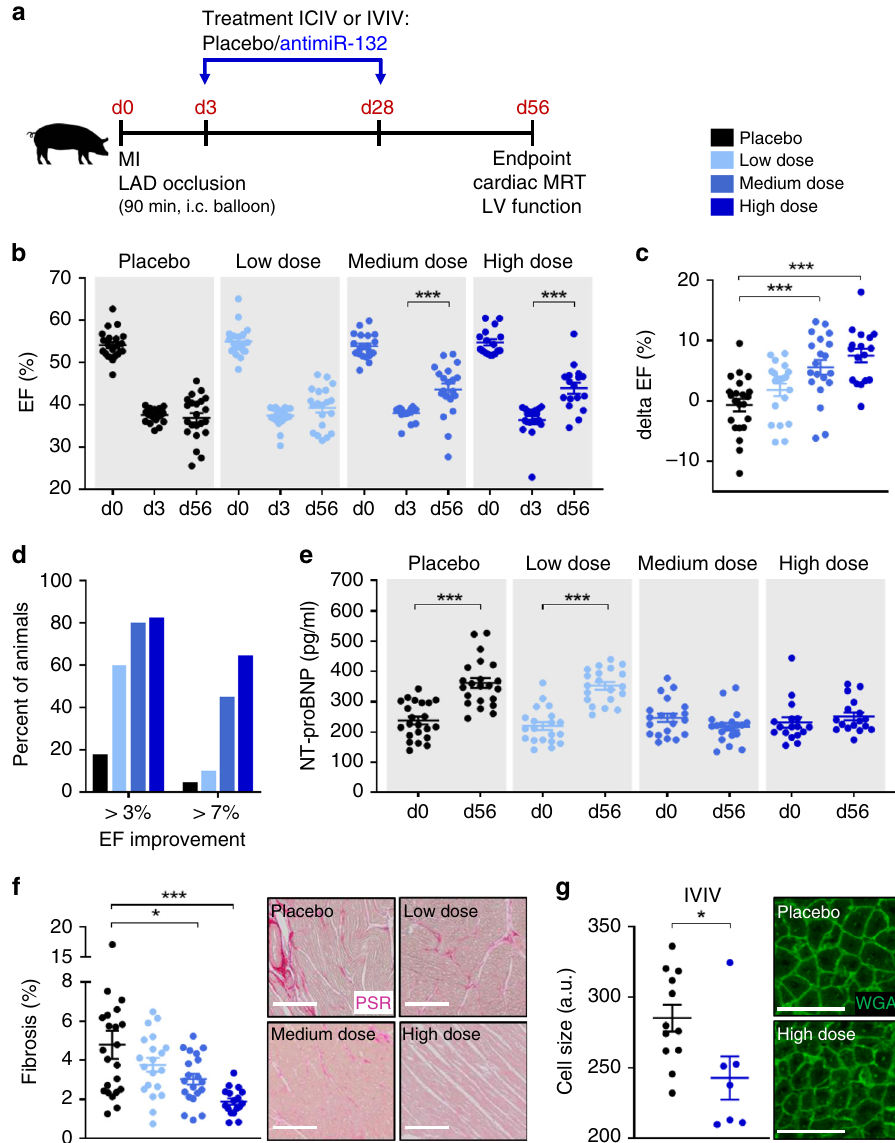
Fig. 4 Proof-of-concept study in a large animal model of post-MI HF. a Study outline of treatment regimen (LAD = left anterior descending coronary artery). b Ejection fraction (EF) at baseline, day 3 and day 56 for different dosing groups of intracoronary/intravenous (ICIV) and intravenous/intravenous (IVIV) treated animals (Placebo: NaCl; Low = 1 mg/kg, Medium = 5 mg/kg and High = 10 mg/kg antimiR-132). c Functional improvement indicated by EF change from day 3 to day 56 (delta EF) for different dosing groups of ICIV and IVIV treated animals. d Responder analysis for different dosing groups of ICIV and IVIV treated animals. e N-terminal prohormone of brain natriuretic peptide (NT-proBNP) levels at baseline and day 56 for different dosing groups of ICIV and IVIV treated animals. f Quanti fi cation and representative micrographs of picrosirius red (PSR) staining of the left ventricular (LV) remote regions for different dosing groups of ICIV and IVIV treated animals (scale bar = 200 µ m). g Quanti fi cation and representative micrographs of wheat germ agglutinin (WGA) staining for cardiac cell size measurement of the LV remote regions of IVIV treated placebo and high dose animals (scale bar = 50 µ m). ICIV and IVIV: Placebo: n = 22, Low dose: n = 20, Medium dose: n = 20, High dose: n = 17. IVIV: Placebo n = 12, High dose: n = 7. Data are mean ± s.e.m; * P < 0.05, *** P < 0.001; unpaired two-sided Mann – Whitney U test (d3 vs. d56) or Kruskal – Wallis test with Dunn ’ s multiple comparison (Placebo vs. treatment Methods mg/kg/application. Wild type (WT) littermates served as controls. At the study Small animal studies and functional analysis . All mouse experiments were endpoint, echocardiography was performed using Vevo 2100 (VisualSonics) under 2% iso fl urane anesthesia, images recorded and analyzed using the Vevo LAB performed in accordance to the relevant regulations and guidelines of the Fed- software 3.1.0 (VisualSonics). eration of European Laboratory Animal Science and with the approval of the governmental animal ethics committee LAVES (Nds. Landesamt für Ver- braucherschutz und Lebensmittelsicherheit). For pharmacological studies, we used Isolation and culture of adult murine cardiomyocytes . Cardiac myocytes of a previously generated 2 transgenic mouse model overexpressing cardiomyocyte- speci fi c miR-132 (C57BL/6N background). Transgenic animals were treated with adult mice were generated by a modi fi ed protocol of the retrograde perfusion antimiR-132 (LNA microRNA Inhibitor, Exiqon/Qiagen), as speci fi ed in the study design Fig. 1a. AntimiR-132 was diluted in 0.9% physiological saline that served as placebo as well. Mice received four intraperitoneal (i.p.) injections at a dose of 20 was perfused for 3min with prewarmed Perfusion buffer (113mM NaCl, 4.7mM